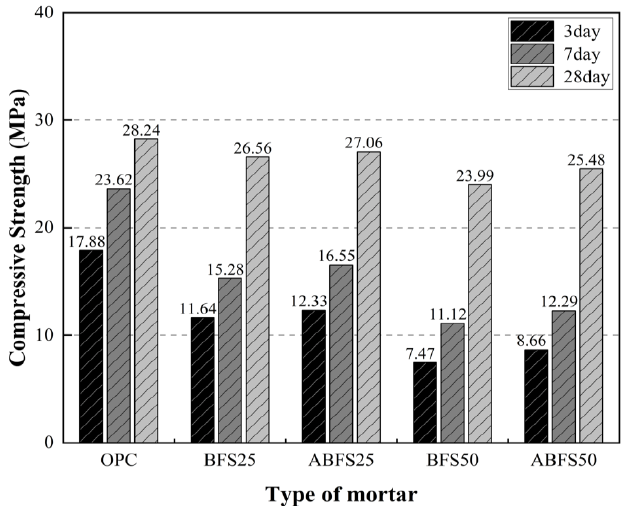
Figure 4. Mortar compressive strength test results (MPa). (1) OPC: Ordinary Portland cement;